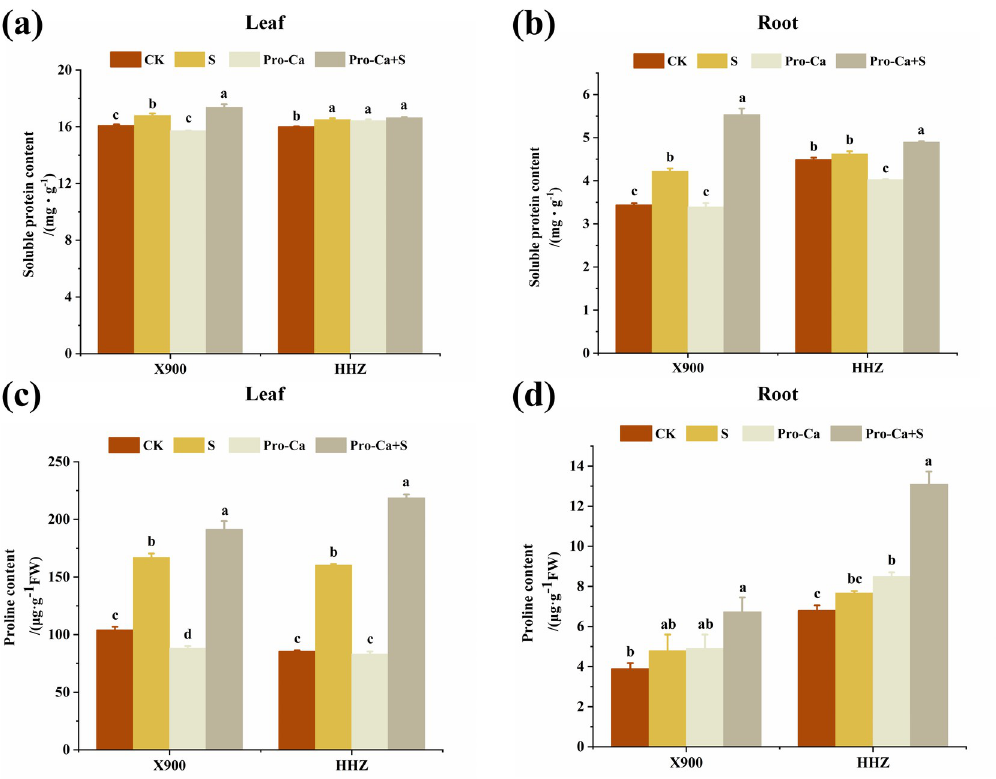
Fig 7. The alleviating effect of exogenous prohexadione-calcium (Pro-Ca) on the antioxidant enzyme activity of rice under salt stress. The soluble protein content in the X900 (left) and HHZ (right) leaves (a) and roots (b); the proline content in the X900 (left) and HHZ (right) leaves (c) and roots (d). Abbreviations: CK (water spraying + 0% NaCl), S (water spraying + 0.3% NaCl), Pro-Ca (100 mg � L -1 Pro-Ca leaf spraying + 0.3% NaCl), and Pro-Ca + S (100 mg � L -1 Pro-Ca leaf spraying + 0.3% NaCl). The numerical value represents the mean ± SE ( n = 3), and different lowercase letters indicate significant differences according to Duncan’s test ( p <